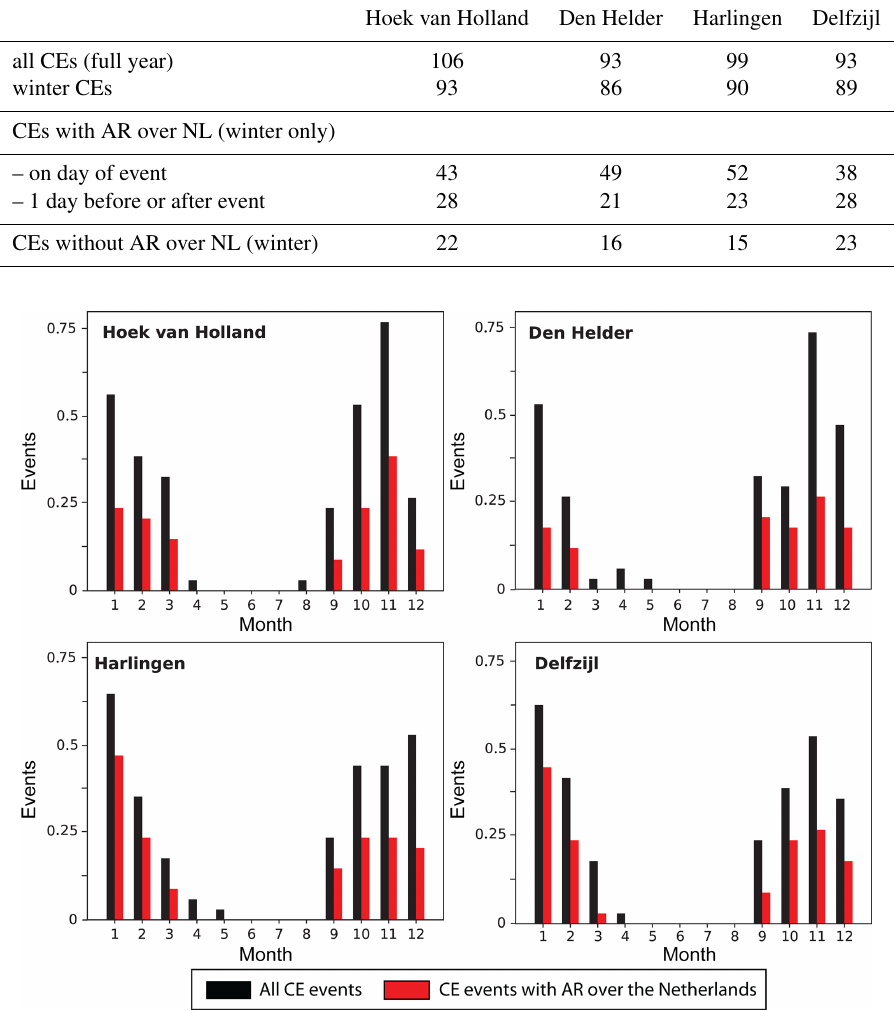
Figure 3. Monthly climatological mean number of compound events at the four coastal stations assessed in this study. Black columns indicate the number of all CEs (CEs with AR + CEs without AR + CEs without ARs ± 1 day), while red bars show the number of CEs with association to an AR over the Netherlands (CEs with